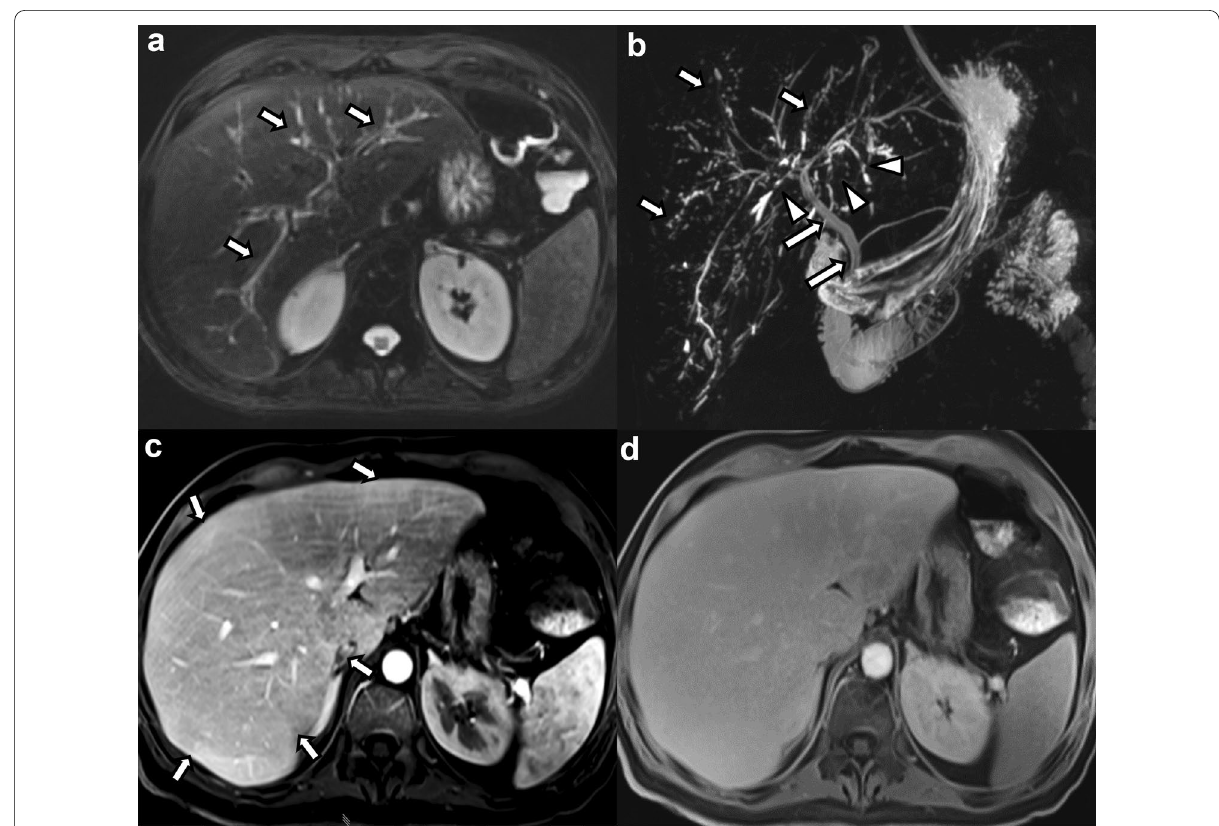
Fig. 3 40-year-old male patient with COVID-19-associated SSC after severe COVID-19 infection with ARDS and ECMO requirement. a Axial fat-suppressed T2-weighted image shows mildly accentuated intrahepatic bile ducts with hyperintense peribiliary signal changes (arrows). b Maximum intensity projection MRCP image shows multifocal beading of the intrahepatic bile ducts (arrows) and multiple short-segment strictures (arrowheads). The extrahepatic biliary tree is spared (long arrows). c Post-contrast subtraction image in the arterial phase shows subtle inhomogeneous parenchymal enhancement with areas of hyperenhancement (arrows). d Hepatobiliary phase image acquired 20 min. after intravenous administration of gadoxetate disodium shows decreased hepatobiliary uptake with decreased liver-to-vessel-contrast. The patient underwent orthotopic liver transplantation and explant pathology revealed findings consistent with a severe ischemic cholangiopathy and grade F2